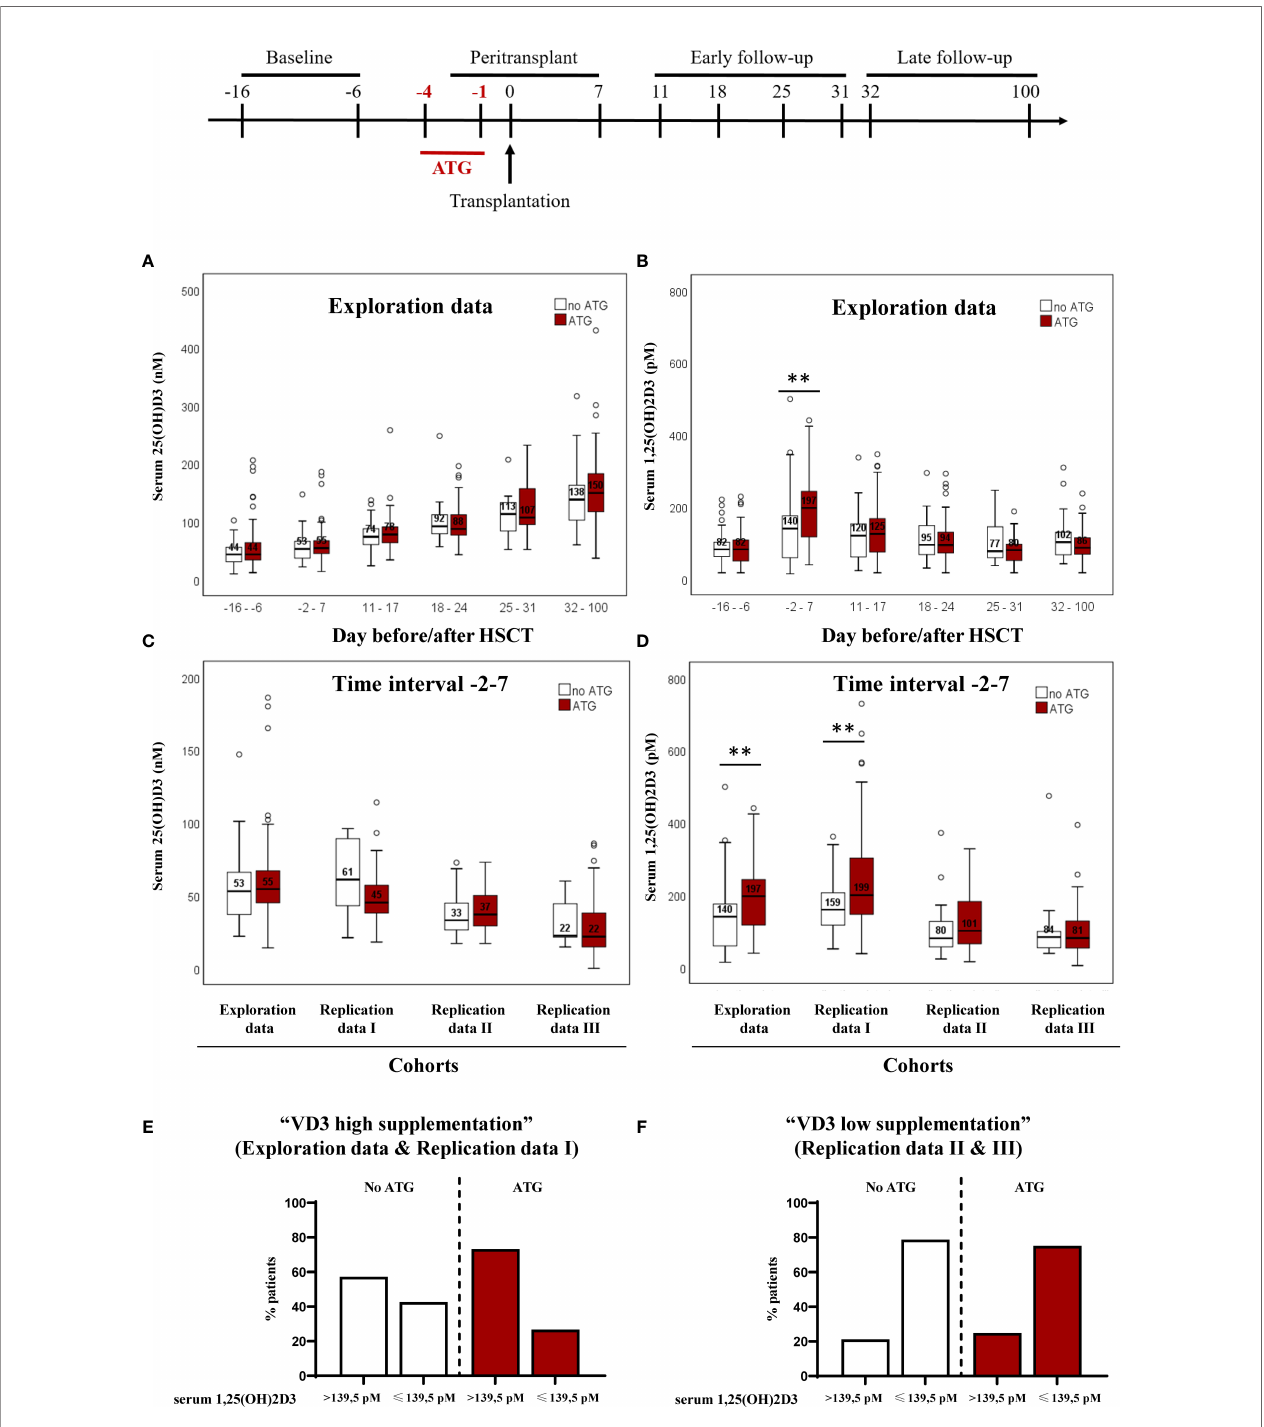
FIGURE 1 | Impact of ATG treatment on 25(OH)D3 and 1,25(OH)2D3 circulating serum levels of patients undergoing hematopoietic stem cell transplantation Panel (A) depicts the median serum 25-hydroxyvitamin D3 levels followed over time in association with ATG treatment for the discovery cohort. In panel (B) , the median serum 1,25(OH)2D3 level is presented. Panel (C) depicts the median serum 25(OH)D3 levels from days -2 to 7 around HSCT of patients receiving ATG and patients that did not received ATG. In panel (D) , the median serum 1,25(OH)2D3 level is presented. Numbers indicate median serum 25(OH)D3 and 1,25(OH)2D3 values, error bars indicate 95% con fi dence interval. Statistical analysis was performed with Mann-Whitney-U test, two-tailed (**p < 0.01). In (E, F) the distribution of patients below and above the calculated cut-off is shown, in relation to ATG treatment for the cohorts with high and low/no vitamin D3 supplementation,